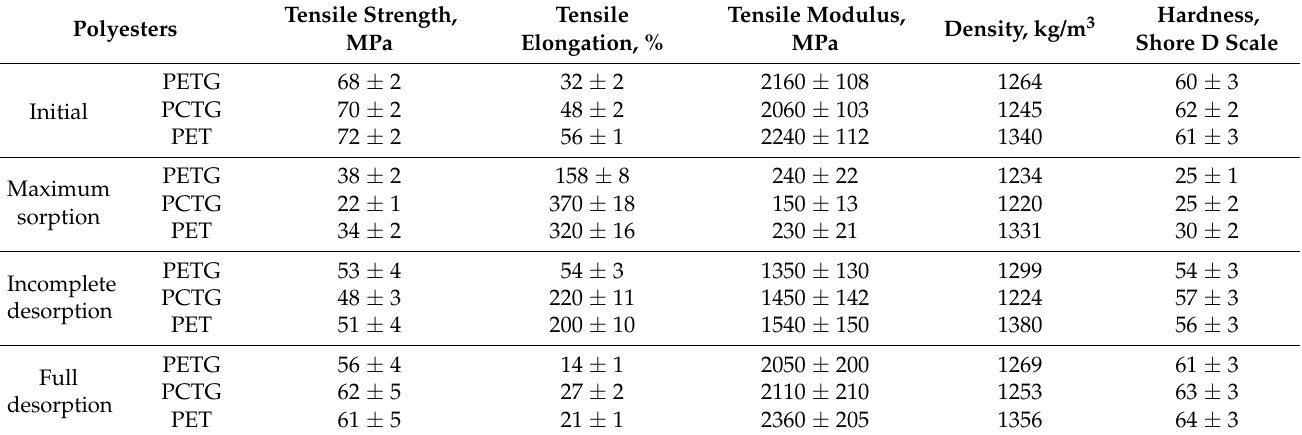
Table 1. Mechanical properties of polyesters under stable sorption conditions (the table shows average